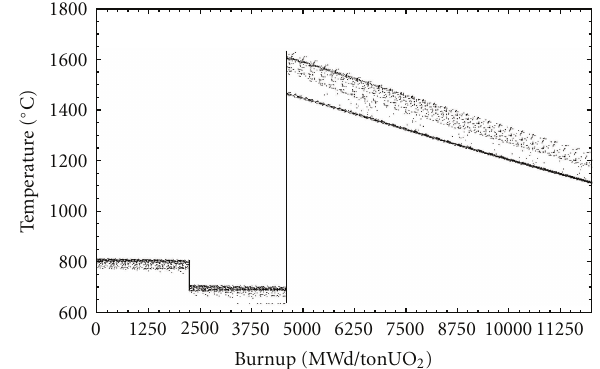
Figure 9: Pellet centre temperature results from the BaCo code probabilistic analysis of a SEU fuel rod of Atucha I (Slightly Enrichment Uranium).